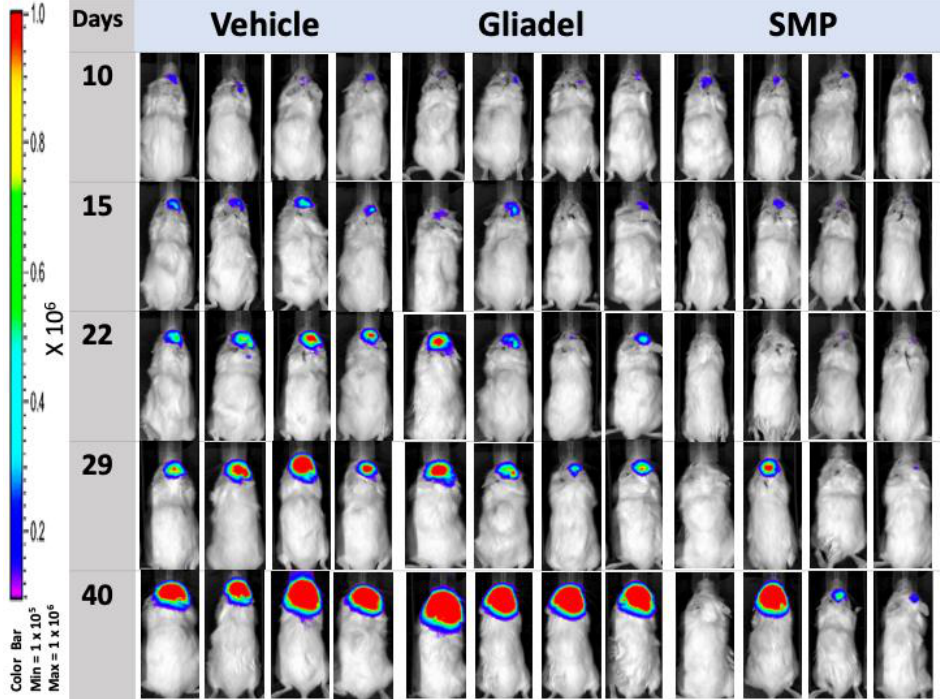
Figure 4. IVIS images of mice bearing U87 xenografts. Representative bioluminescent images of mice bearing U87 xenografts were taken on days 10, 15, 22, 29, and 40 following treatment with TMZ vehicle, TMZ-combined Gliadel, or TMZ-combined SMPs.